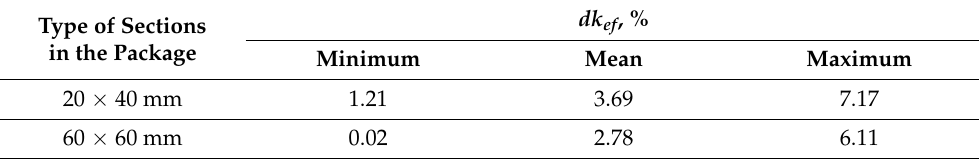
Table 2. The minimum, mean and maximum values of dk ef defined by Equation (25). Type of